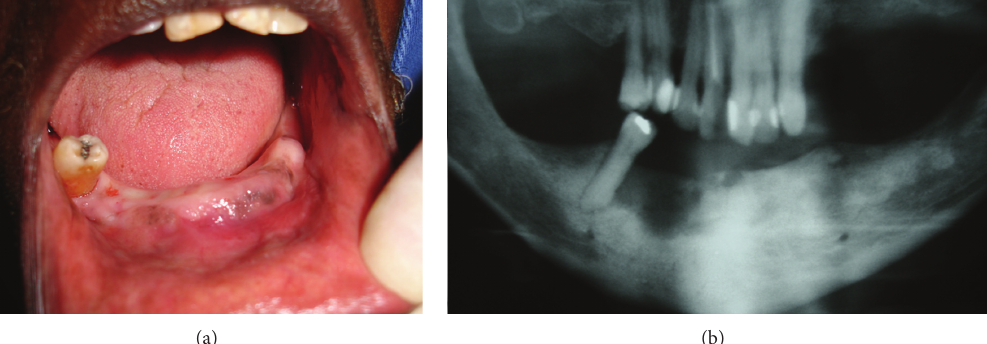
Figure 1: ((a) and (b)) Initial clinical and radiographic features of osteomyelitis, located in the anterior mandible, consistent with necrotic bone.